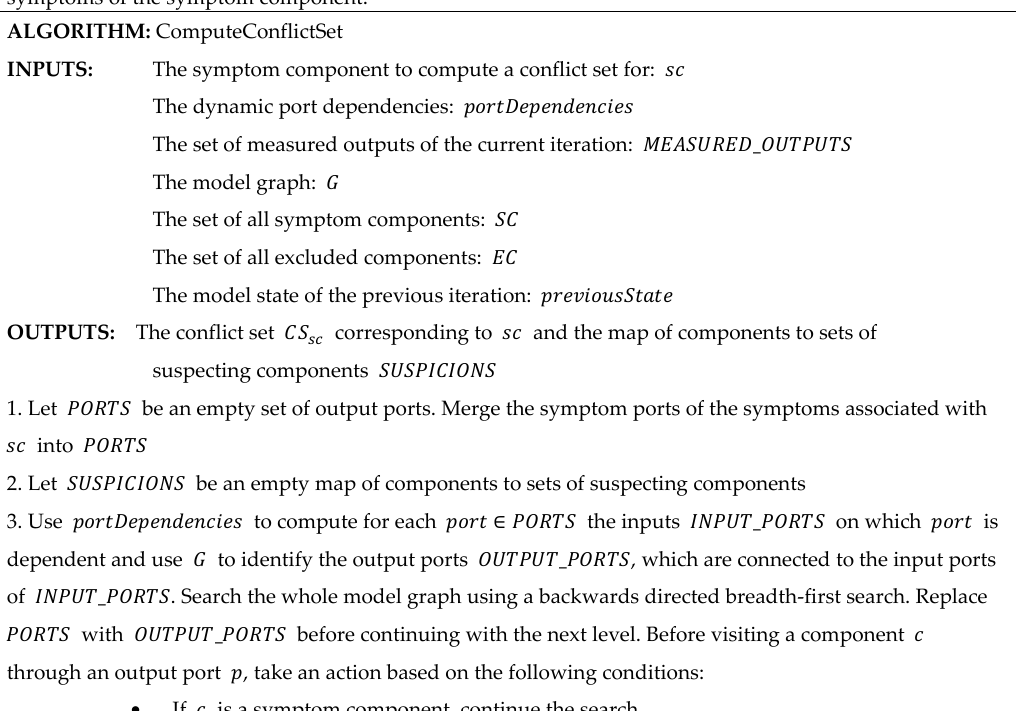
Algorithm 3. Pseudo code of the ComputeConflictSet-function used to compute a conflict set, given a symptom component, so that a malfunction of a component of the conflict set would explain the observed symptoms of the symptom